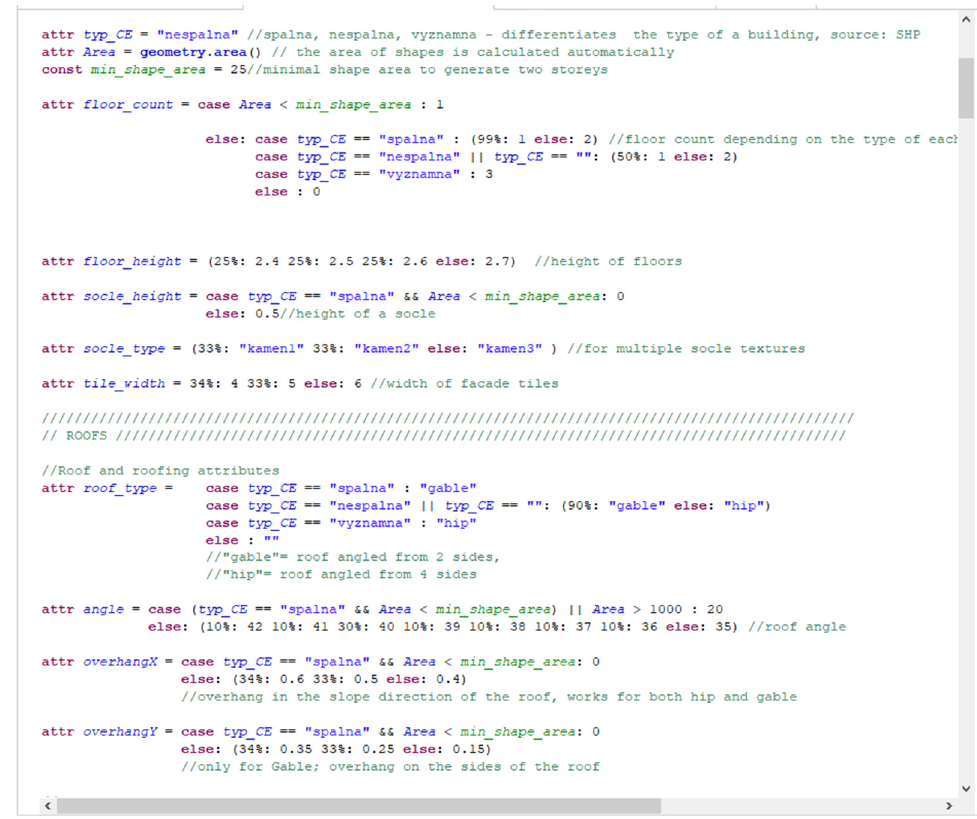
Figure 5. Example of used attributes for the procedural modelling of buildings.